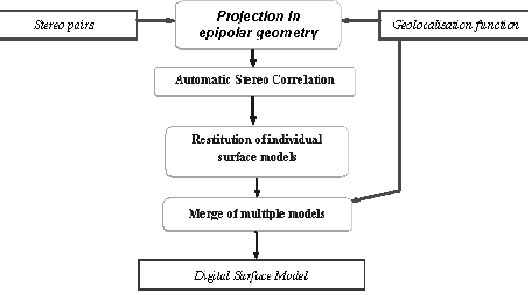
Figure 1. Flowchart representing the DSM extraction procedure